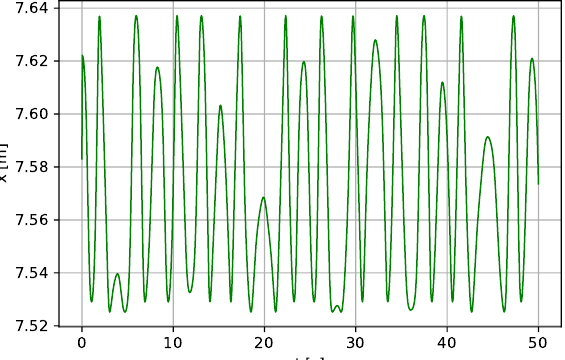
s m − 1 , ω = 0.5 rad s − 1 . · · ·